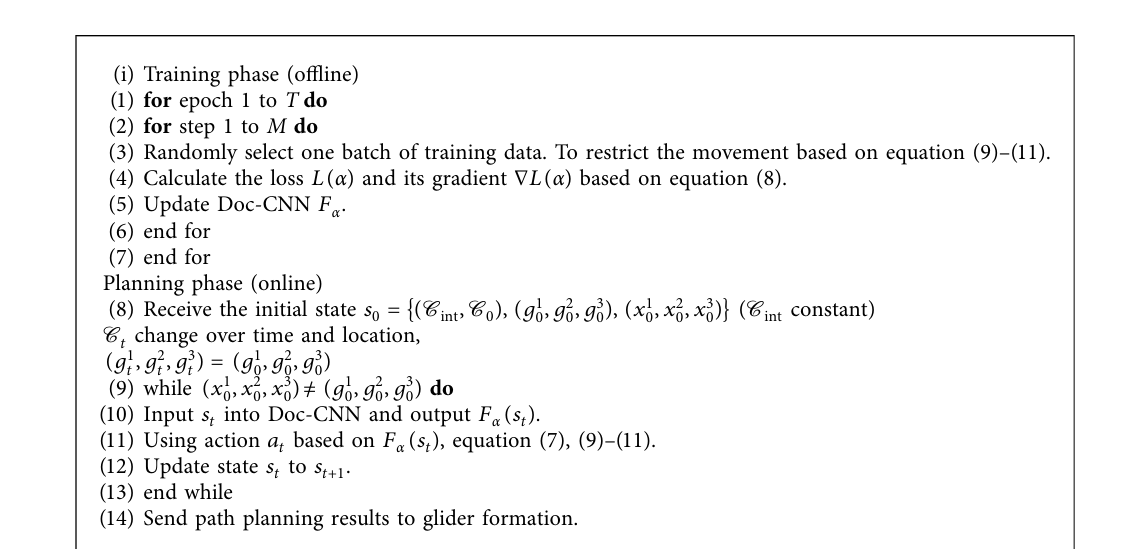
A LGORITHM 1:Learning-based path planning